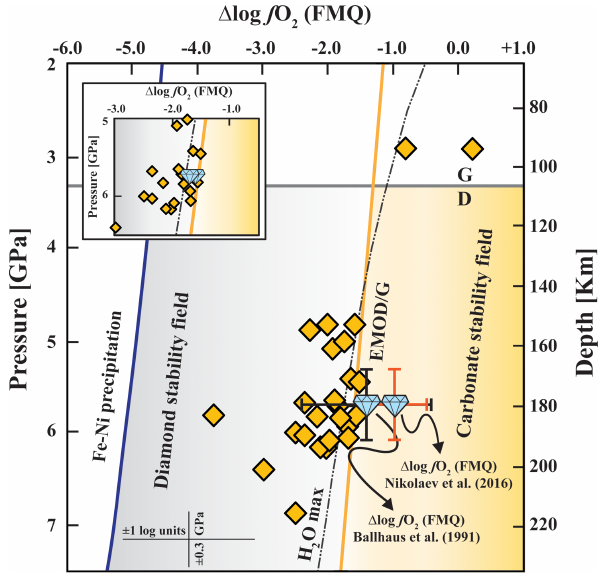
Figure 4. (cid:49) log f O 2 (FMQ)–pressure diagram showing the dis- tribution of well-equilibrated xenoliths from Udachnaya (yellow rhombi) (data source: Tables S2) and the calculated (cid:49) log f O 2 (FMQ) value for the studied inclusion pair (diamond). (cid:49) log f O 2 (FMQ) values and associated uncertainties for mantle xenoliths were calculated with the Miller et al. (2016) oxybarometer (see Table S2); typical uncertainties are shown for reference. Inset: the same data but assuming that the inclusion was trapped at ∼ 100 ◦ C higher T and then re-equilibrated during long-term mantle stor- age. (cid:49) log f O 2 (FMQ) values calculated for the inclusion pair sug- gest diamond formation at relatively oxidized conditions near the EMOD buffer, for both the scenarios in which the inclusion did not re-equilibrate after incorporation or was trapped at higher T . EMOD/G buffer is calculated for a 35mWm − 2 geotherm from the thermodynamic dataset of Holland and Powell (2011) (see